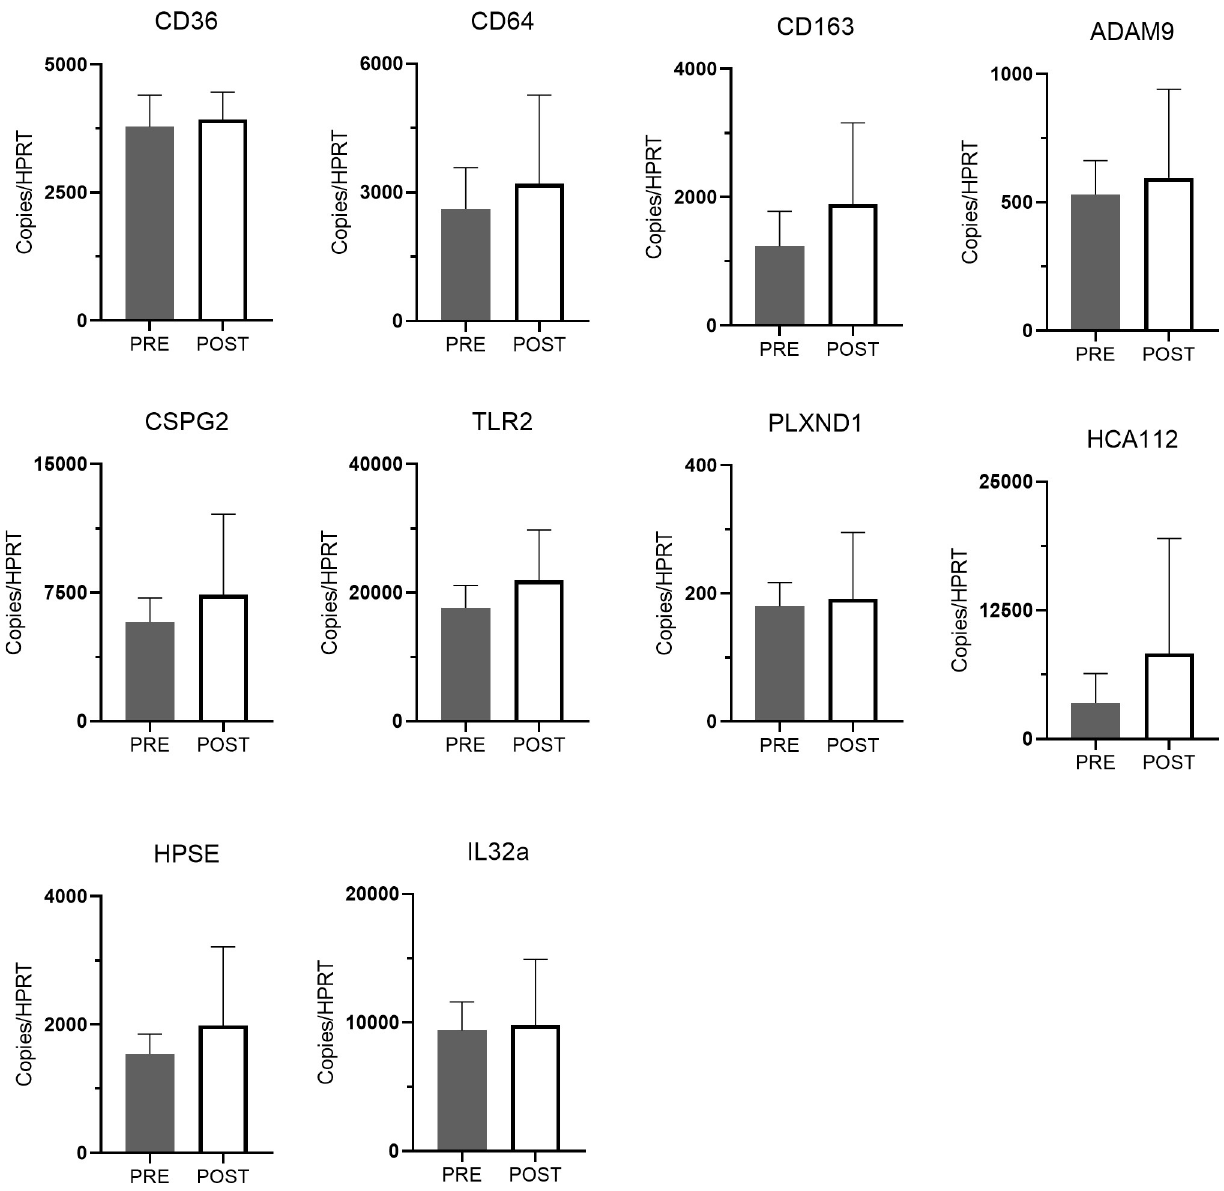
Fig 4. Effect of inhaled AZLI on mean leukocyte gene expression from whole blood pre and post treatment. Solid columns represent pre-treatment; open columns represent post-treatment. Bars represent means ( ± SD) relative to the detection of housekeeping gene HPRT . Differences analyzed by paired t-test following log